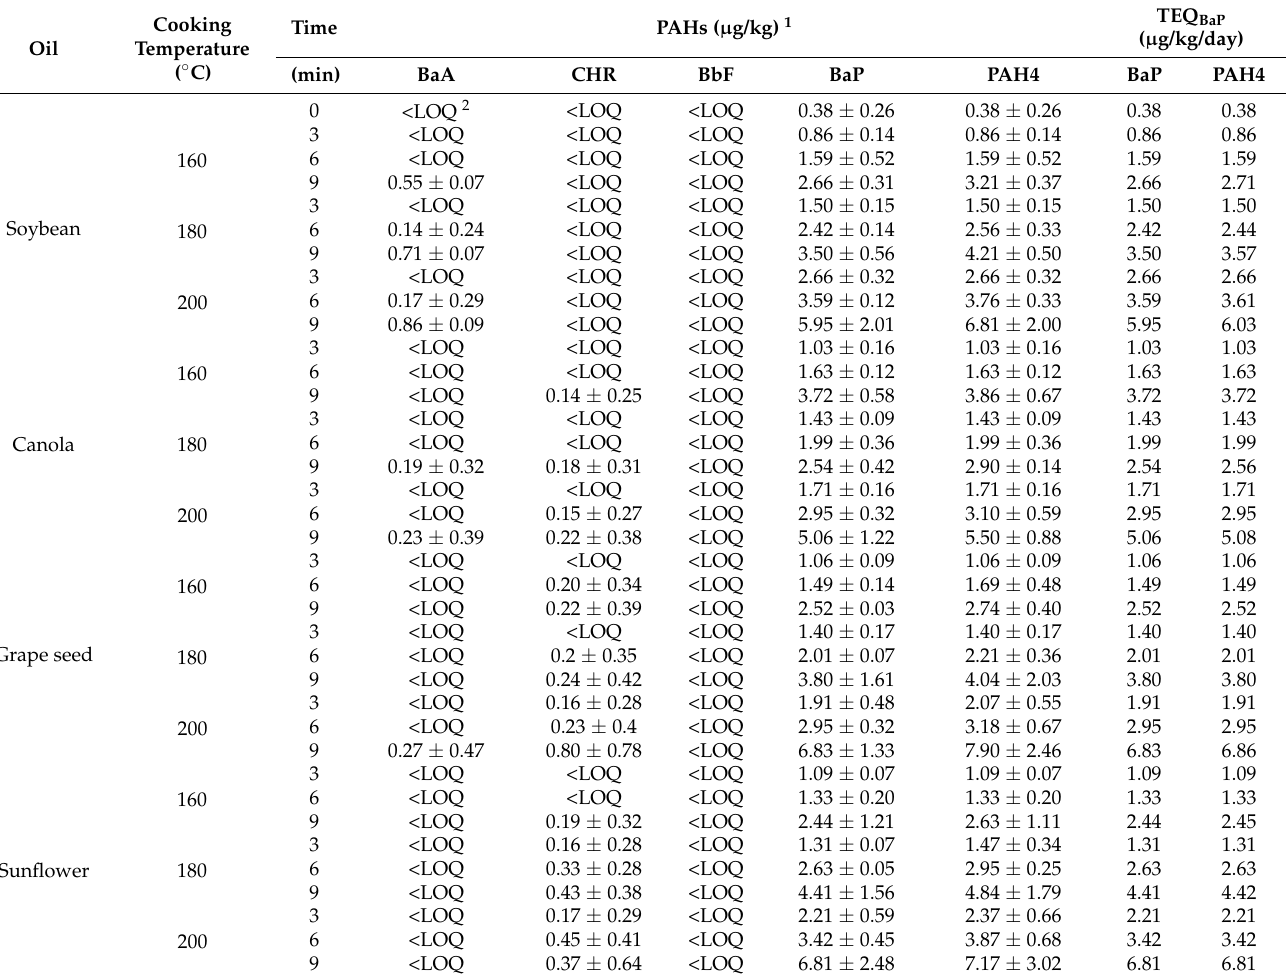
Table 3. Changes in the concentration of PAHs in deep-fat fried pork according to treatment